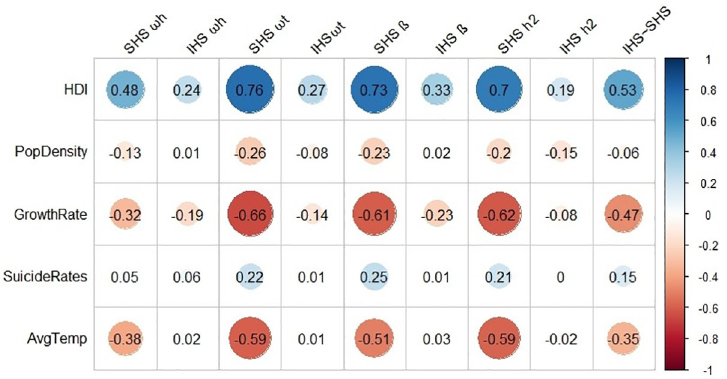
Fig 2. Country level correlations between objective country level variables and happiness variable reliabilities. Note . IHS = Interdependent Happiness Scale, SHS = Subjective Happiness Scale, ω t = total common variance, ω h = general factor saturation, β = smallest split half reliability, h2 = average communality score, HDI = Human Development Index, PopDensity = population density, GrowthRate = population growth rate, SuicideRate = suicide rate, AvgTemp = average daily temperature.